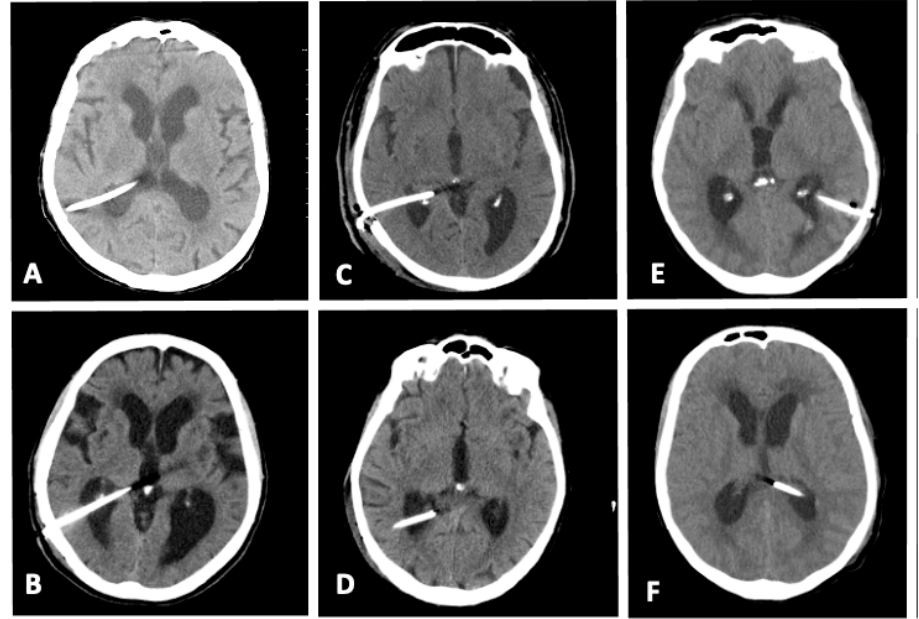
Figure 2. CT images of correct positioning of the ventricular catheter; ( A – D ) catheters are inserted in the right ventricle; ( E , F ) catheters are inserted in the left ventricle.